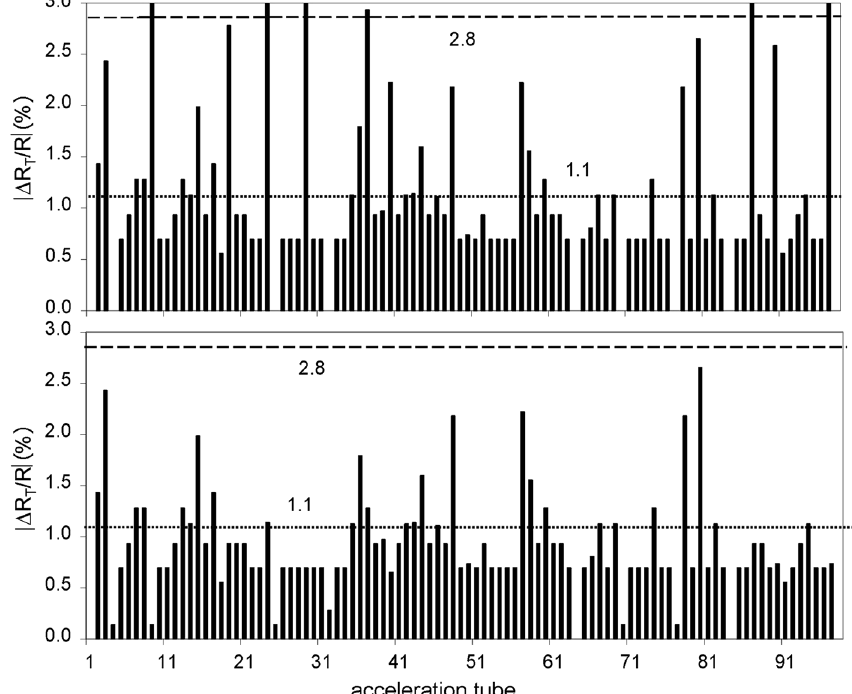
j in the accelerating tubes. The max